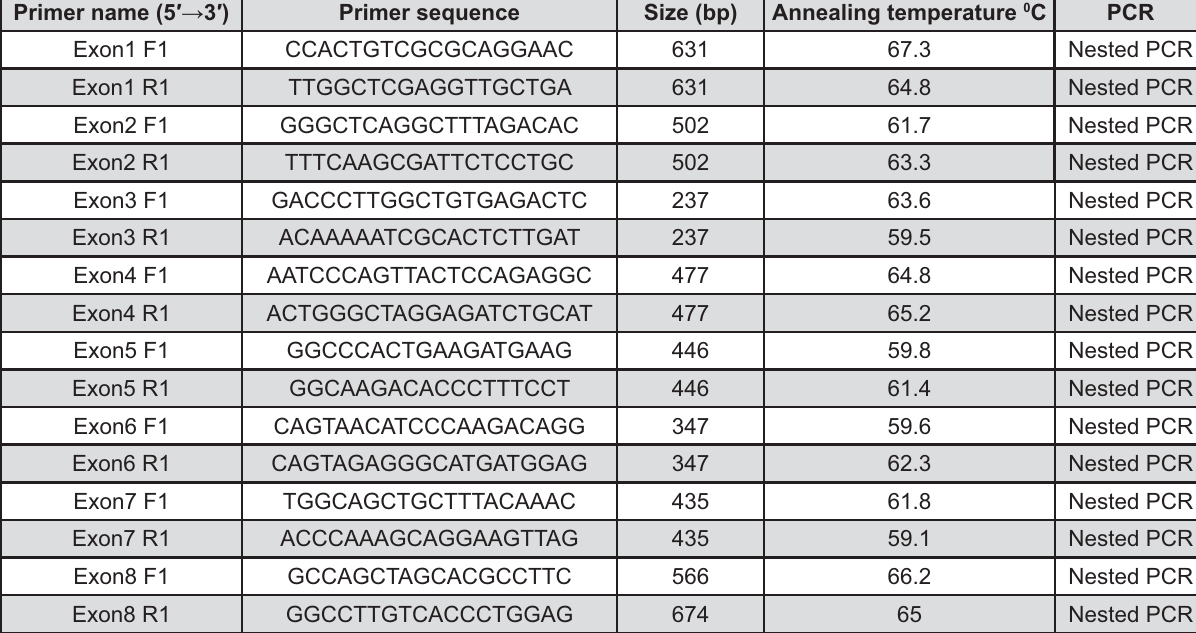
Figure 2- The sequence of EDA